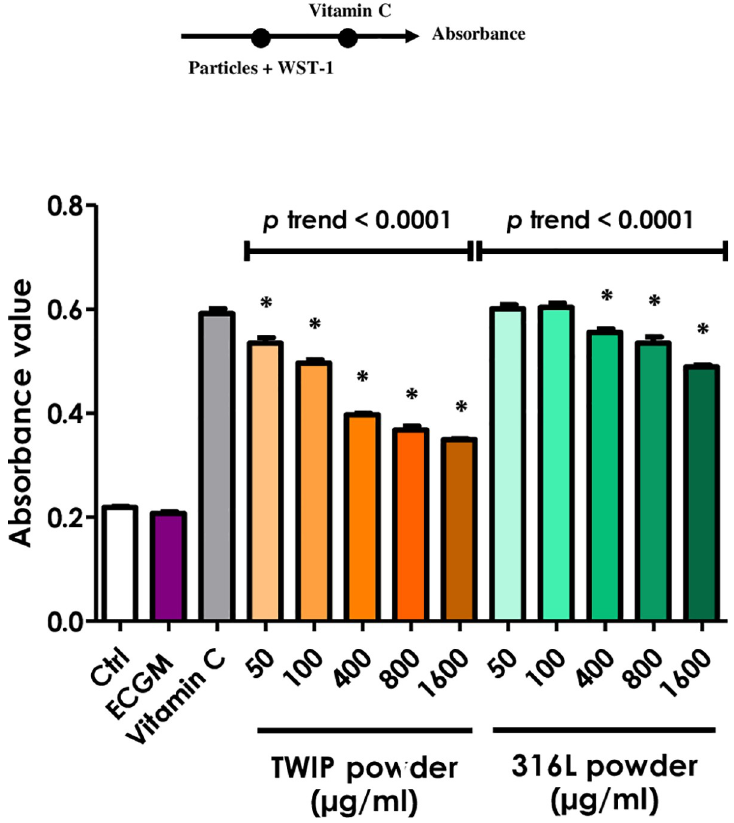
Fig 8. TWIP steel particles react with the WST-1 reagent and block formazan formation. Increasing concentrations of TWIP steel or 316L steel powders were incubated with 10% WST-1 reagent. Then, ascorbic acid (0.5 mM) was added and the absorbance was immediately measured at 450 nm, with 690 nm as reference. Ctrl: 50% ECGM– 50% WST-1; ECGM: 100% cell culture medium; Vitamin C: Vitamin C (0.5 mM) + WST-1. Values are means ± SEM (n = 4), � p < 0.05 relative to control (One-way ANOVA followed by a Dunnett’s multiple comparison). The trend test included controls. On the top: timeline of experiment